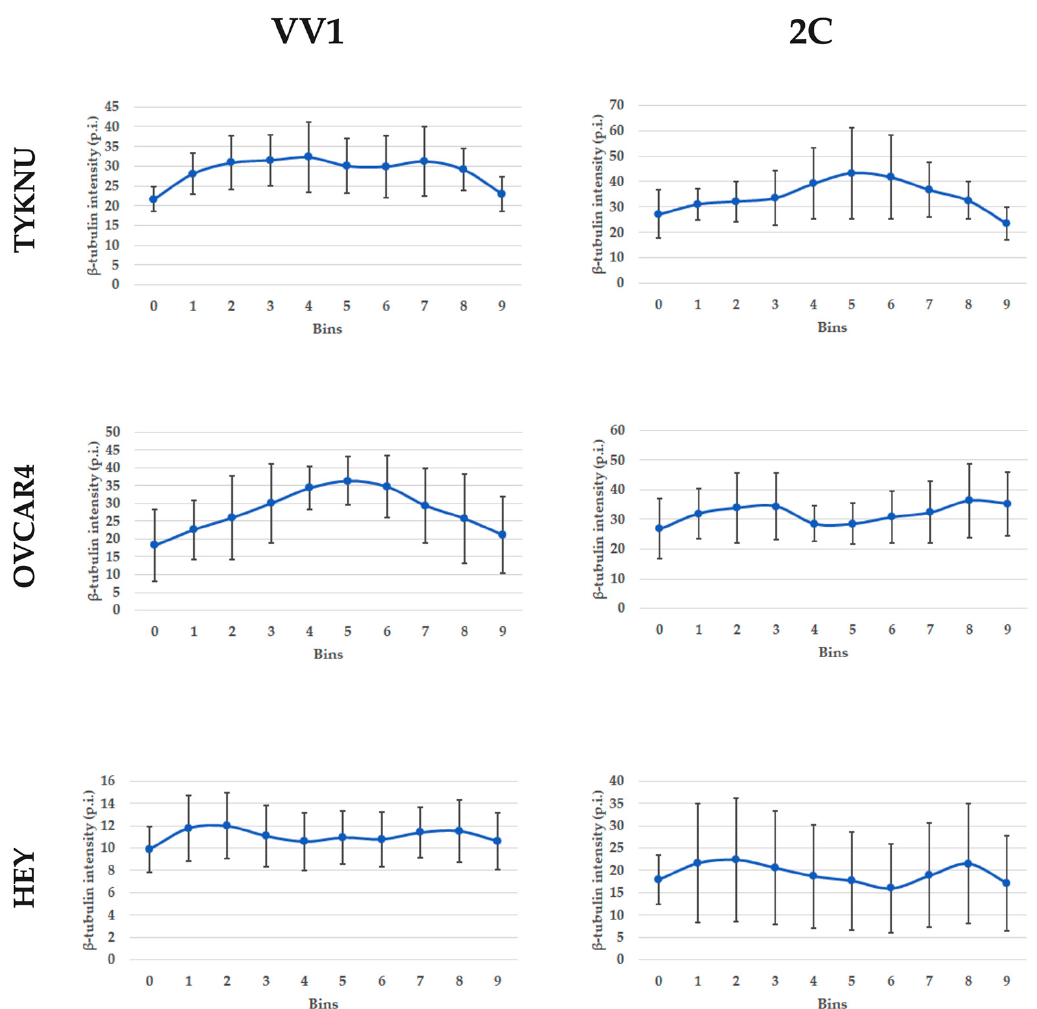
Figure 9. β -tubulin fluorescence intensity profile of cell lines treated with VV1 and 2c. X-axis: cell centroid crossline divided into 10 equal sections (bins). The three most external bins (1–3 and 8–10) indicate the cell periphery while the inner ones (4–7) indicate the cell center. Y-axis: average β -tubulin fluorescence intensity for each bin expressed as mean pixel intensity. Points bars indicate the 95% confidence interval (CI).